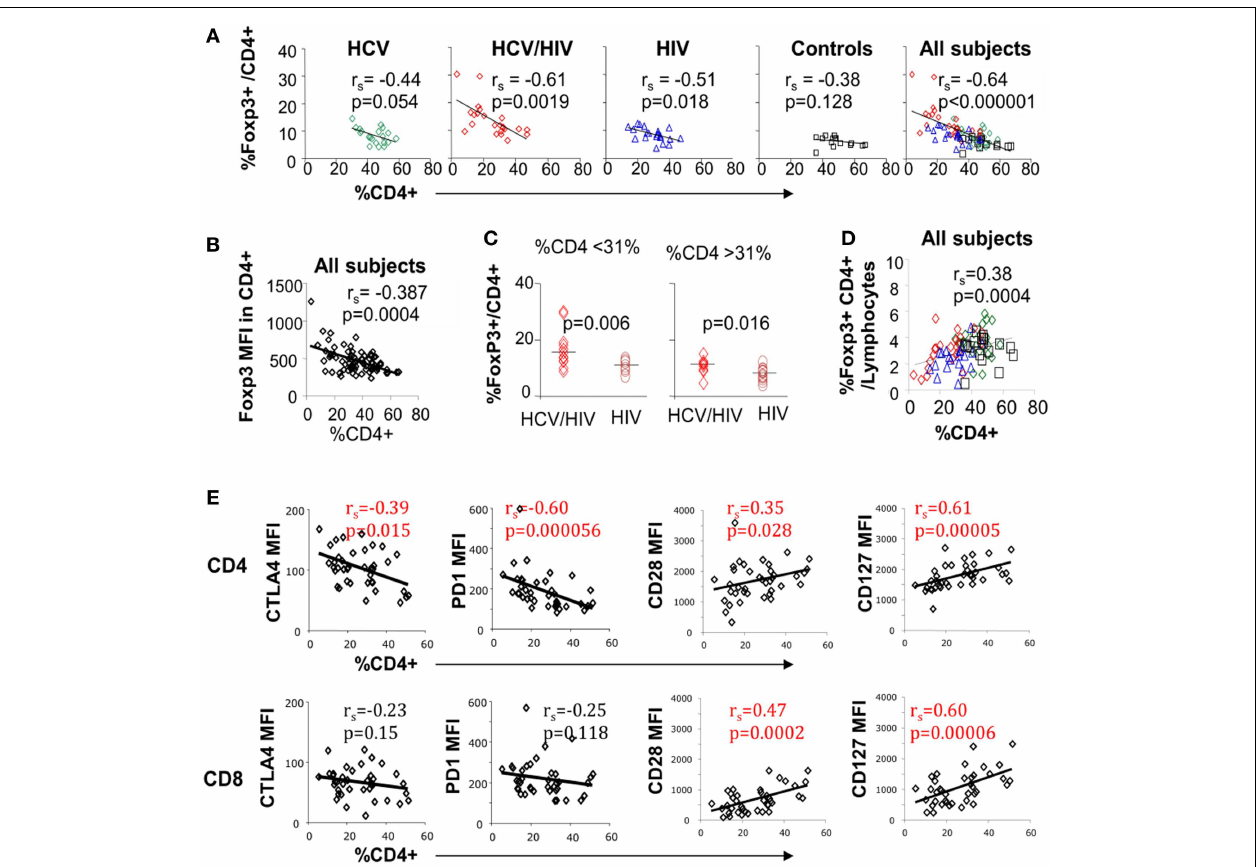
compartment is compared between in HCV/HIV-coinfected and HIV-monoinfected patients with CD4T cell frequency below or higher than a cutoff of 31% (median CD4T cell frequency). P -values are calculated by non-parametric Mann–Whitney U test. (D) Frequency of FoxP3 + CD4 + T cells in live lymphocyte compartment is compared with CD4T cell frequency with Spearman rank-order correlation and P -values. (E) CTLA-4, PD-1, CD28, and CD127 mean fluorescence intensities (MFI) in CD4 and CD8T cells are compared with overall CD4T cell frequency in live lymphocyte compartment. Spearman rank-order correlation and P -values are